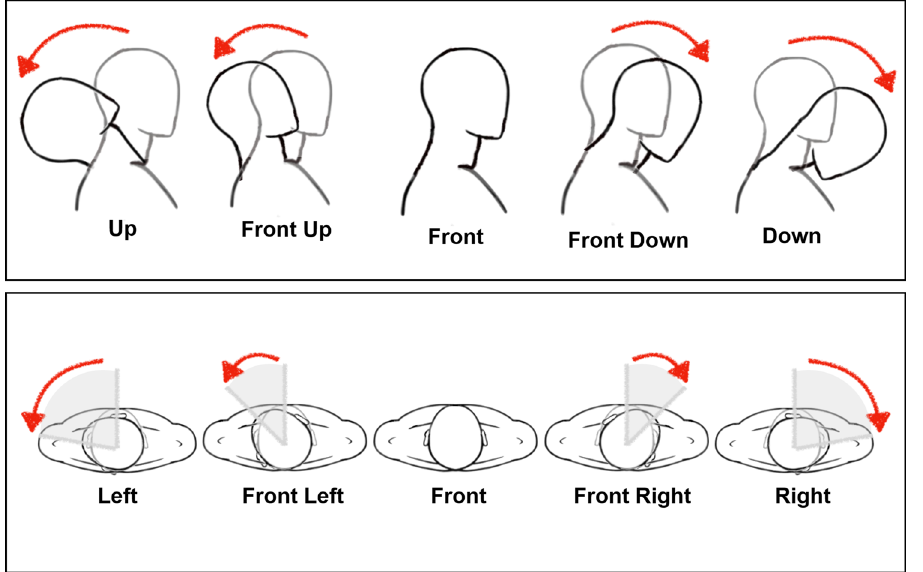
Figure 1. Motion